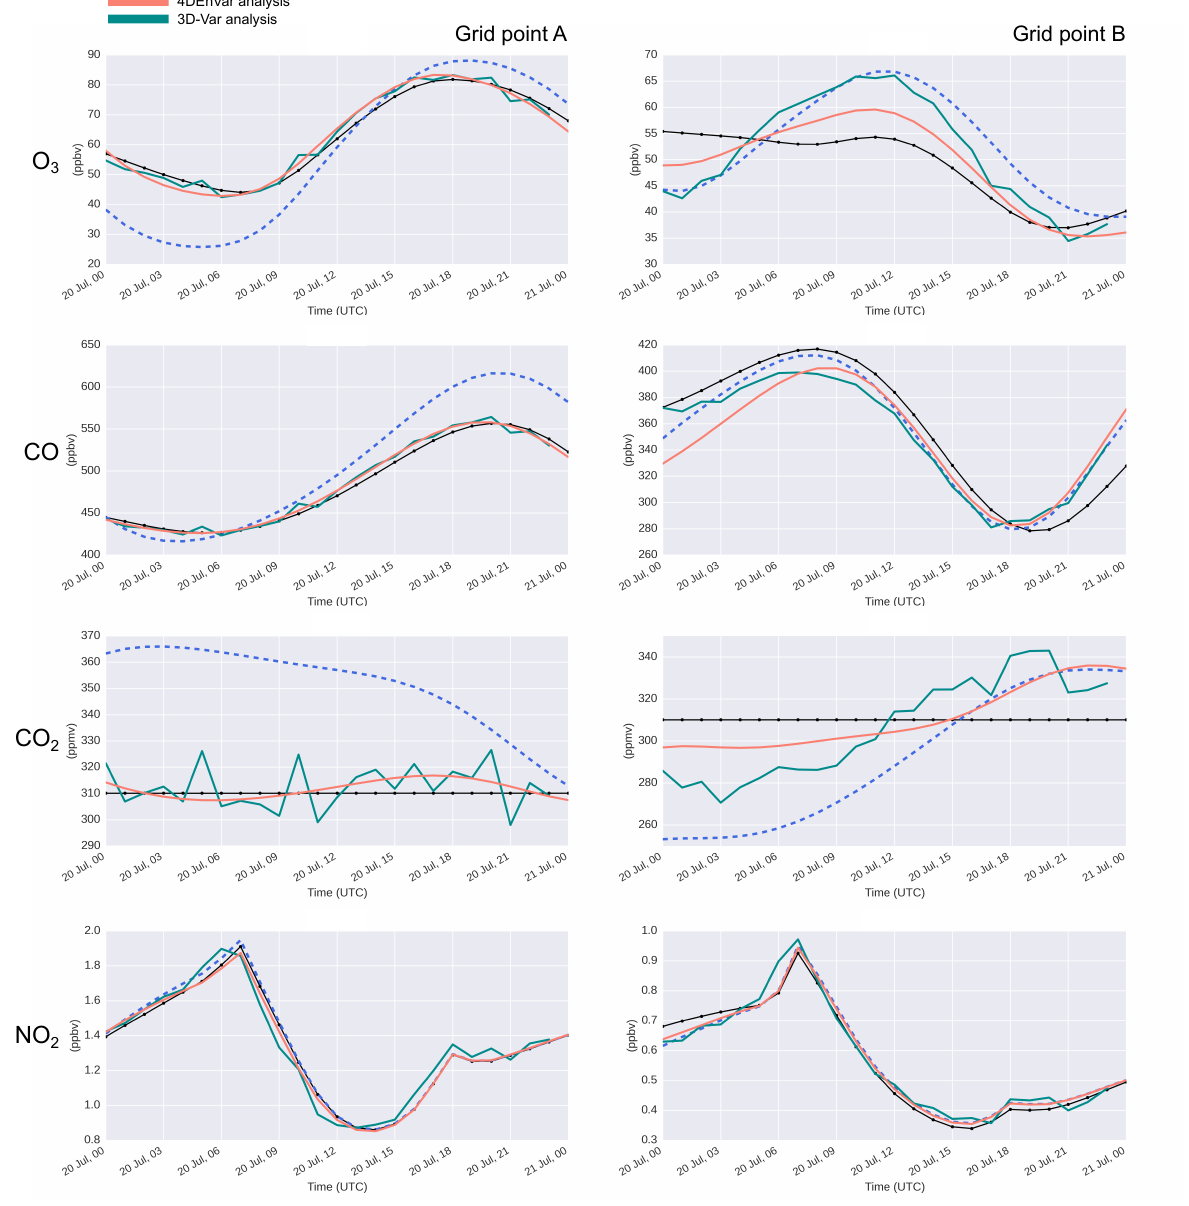
Figure 3. DA results with a perfect model hypothesis. Temporal trajectories for the four assimilated species are shown from top to bottom (O 3 , CO, CO 2 and NO 2 ). Forecast, 3D-Var/4DEnVar analyses and truth are shown in each plot for the grid points A (left plots) and B (right plots) depicted in Fig.